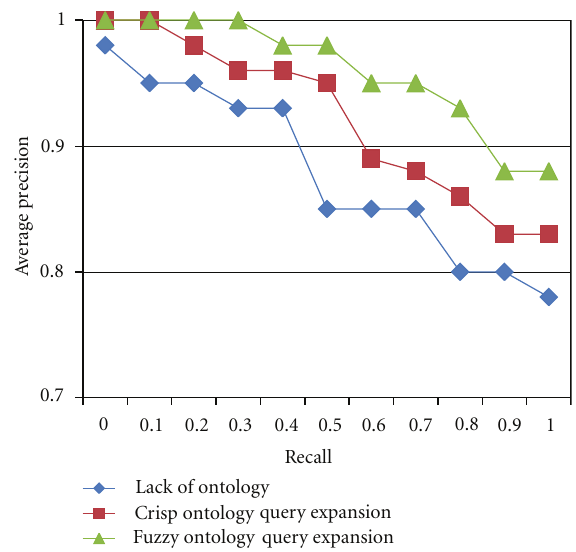
Figure 5: The average precision plot for three situations: lack of ontology, crisp ontology query expansion and fuzzy ontology query